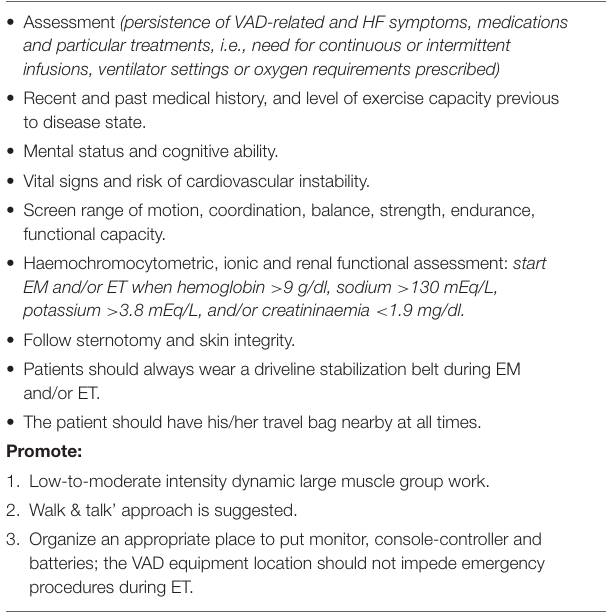
TABLE 3 | Early mobilization and exercise modalities in e-CR: step-up mobilization ( duration of single exercise is not contemplated and neither is step-back if clinical problems occur